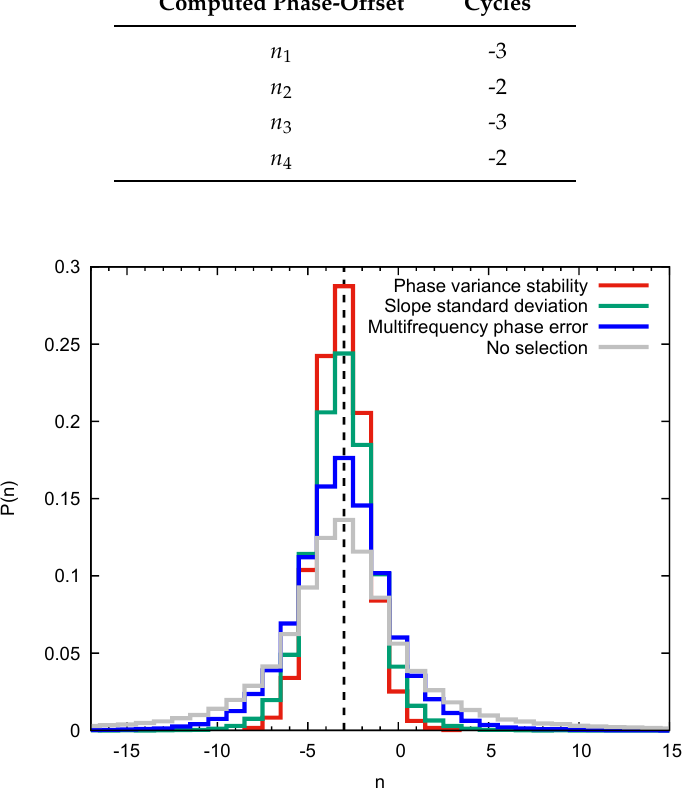
Figure 8. Normalized histograms of the estimated phase-offset values n for region 3. The gray line histogram represents the case where no selection of PS f is applied. For other cases, the PS f population is selected using three different criteria. The vertical dashed line indicates the expected phase ambiguity. Similar figures are obtained for the three other regions.